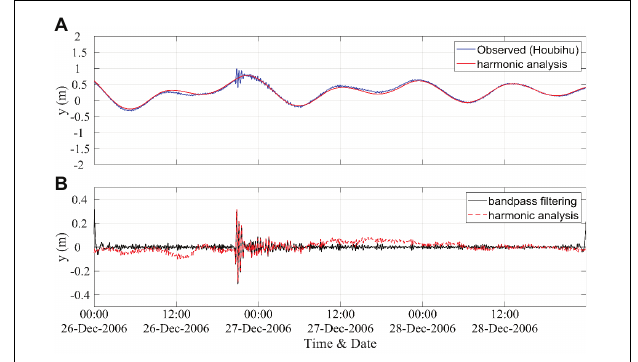
FIGURE 11 | Comparison of tsunami height extraction by the bandpass filtering method and tidal pattern analysis. (A) The time series of surface elevation including a tsunami; (B) The extraction of tsunami heights by two methods.